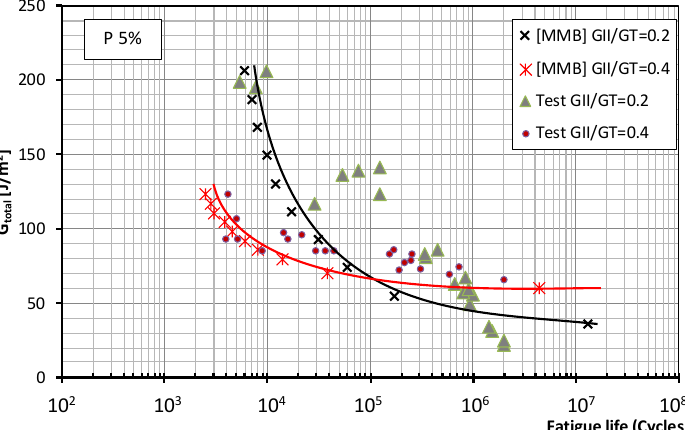
Figure 3. Material fatigue curves, MMB test, for a 5% probability of fracture and two mode mixity ratios: 0.2 and 0.4.